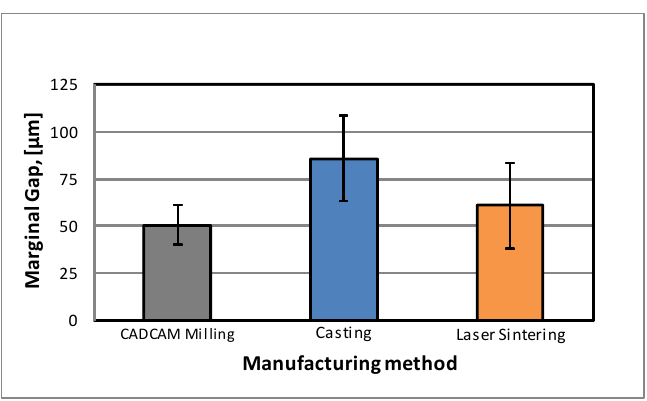
Figure 4. SEM-Micrographs of discrepancy measurement obtained by di ff erent processes: ( a ) CADCAM, ( b ) Casting, ( c ) Laser sintering.